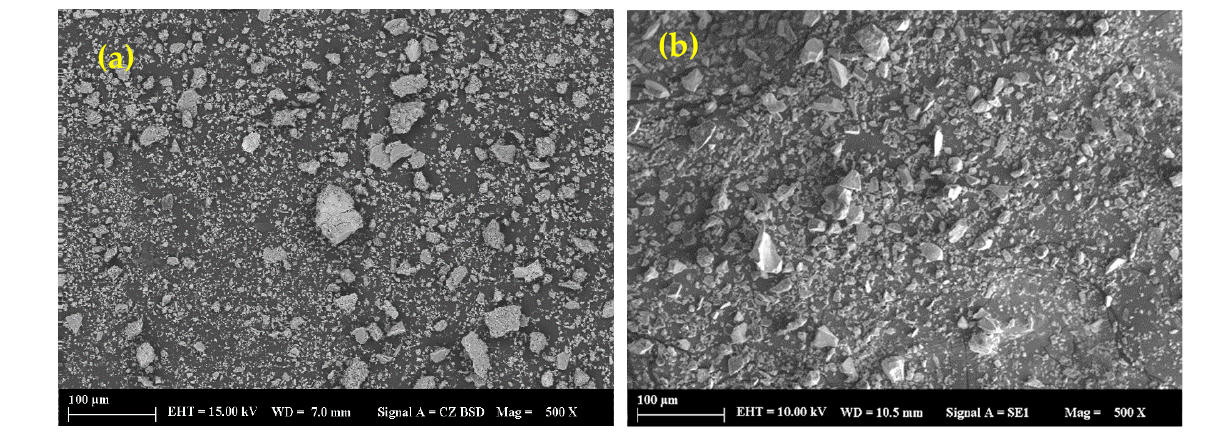
Table 1. Oxide compositions of BOFS and GGBFS.